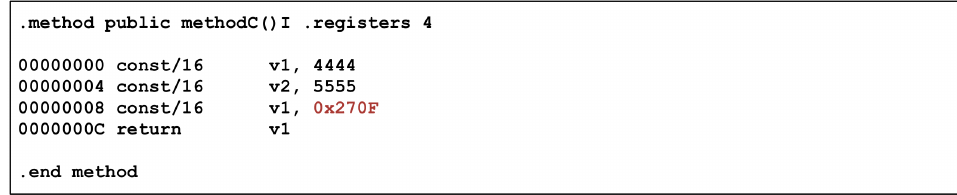
Figure 19. Disassembled MethodC with DexGuard .